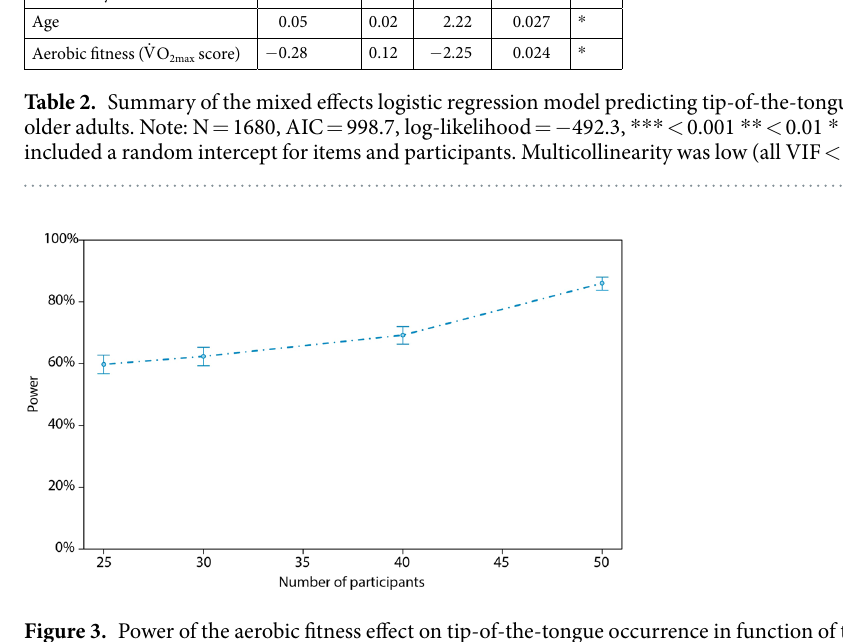
Figure 3. Power of the aerobic fitness effect on tip-of-the-tongue occurrence in function of the number of participants. Power is estimated as the chance of detecting a non-zero effect of aerobic fitness on the probability of experiencing a tip-of-the-tongue state in a simulation study with 1000 simulation runs. The figure indicates that already a small sample size leads to a high power of the study. Error bars represent the 95% confidence interval for the proportion of simulation runs in which the null-hypothesis was